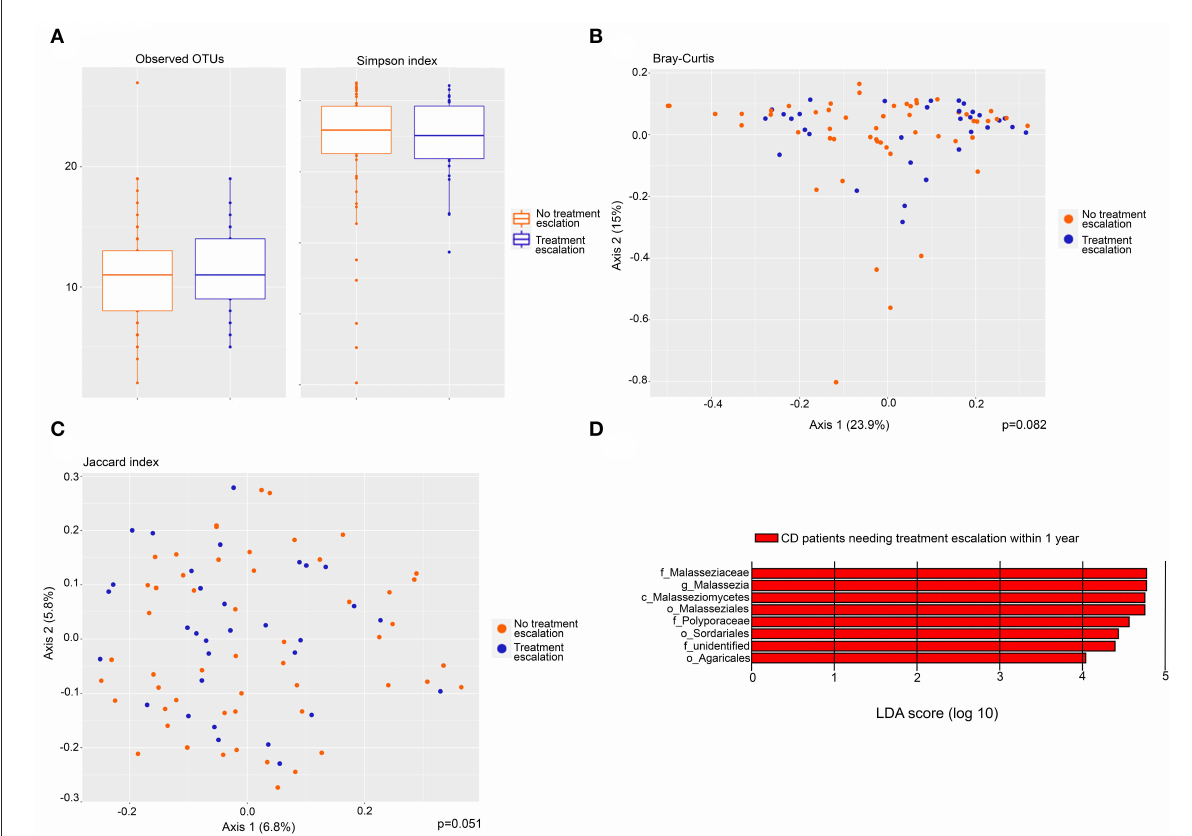
FIGURE5 Fungal microbiota in CD patients needing treatment escalation ( n = 17) within the first year after biopsy sampling compared to CD patients not needing treatment escalation ( n = 27). (A) Fungal alpha-diversity, according to observed operational taxonomic units (OTUs) (left) and Simpson index (right), boxplots colored according to need for treatment escalation (blue) and no need for treatment escalation (red). (B) Beta-diversity. Principal coordinates analysis of Bray–Curtis dissimilarity with samples colored according to the need for treatment escalation (blue) and no need for treatment escalation (red). The fraction of diversity captured by the coordinate is given in percentage on axes 1 and 2. Groups were compared using the Permanova method. (C) Principal coordinates analysis of Jaccard index with samples colored according to need for treatment escalation (yes = blue, no = red). The fraction of diversity captured by the coordinate is given in percentage on axes 1 and 2. Groups were compared using the Permanova method. (D) Fungal taxa overrepresented in CD patients needing treatment escalation within 1 year compared to CD patients not needing treatment escalation, illustrated in a histogram with Linear Discriminant Analysis (LDA) score computed using linear discriminant analysis effect size